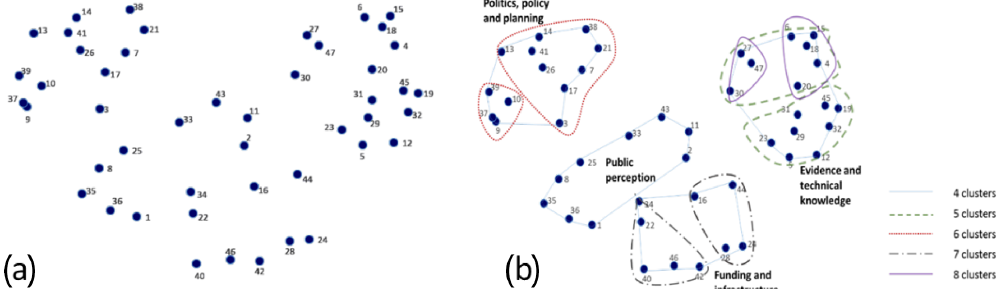
Figure 3. (a) Multidimensional scaling showing similarity and dissimilarity of the 47 barrier statements. (b) Ward’s hierarchical cluster analysis, clusters